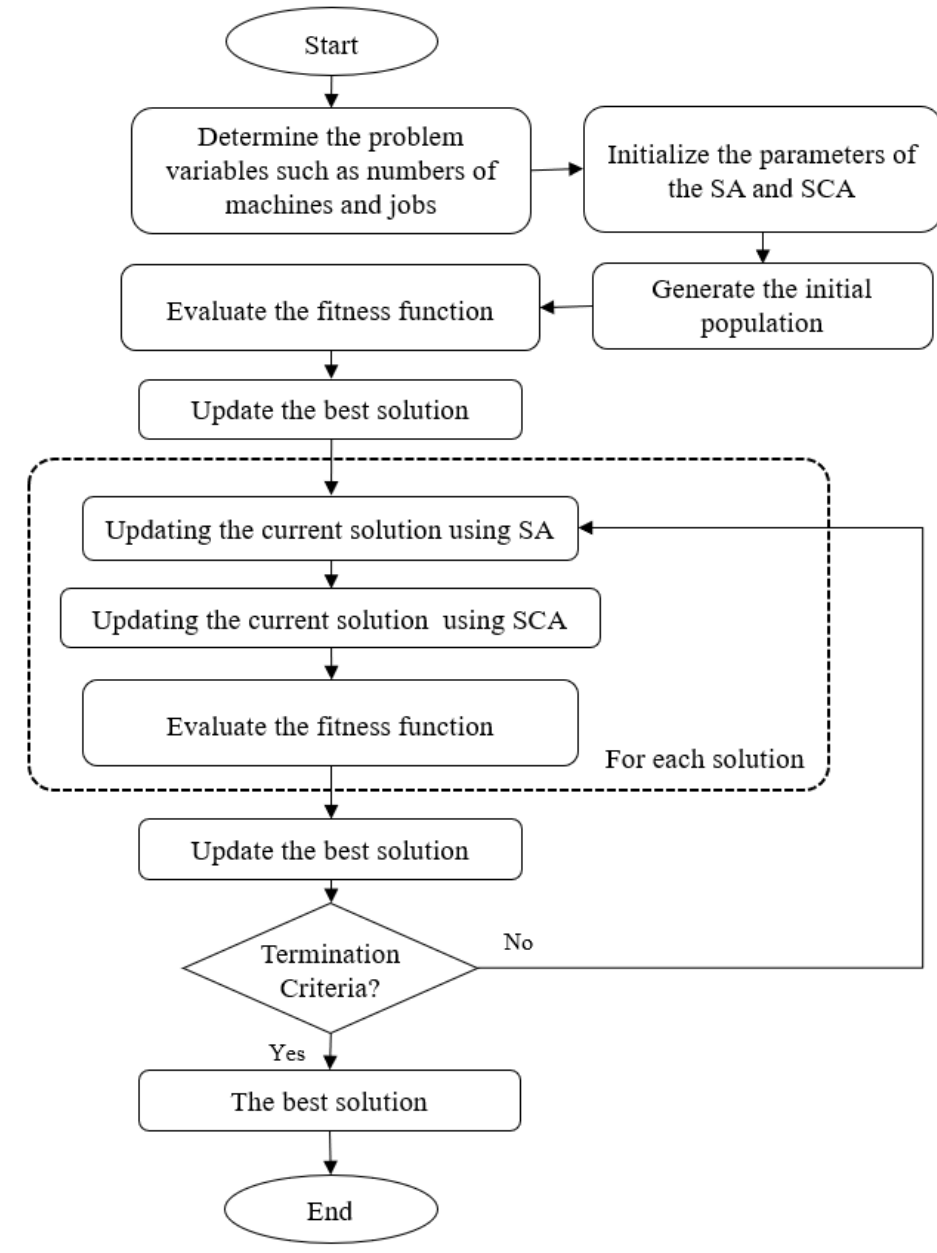
Figure 1. The entire phases of the proposed